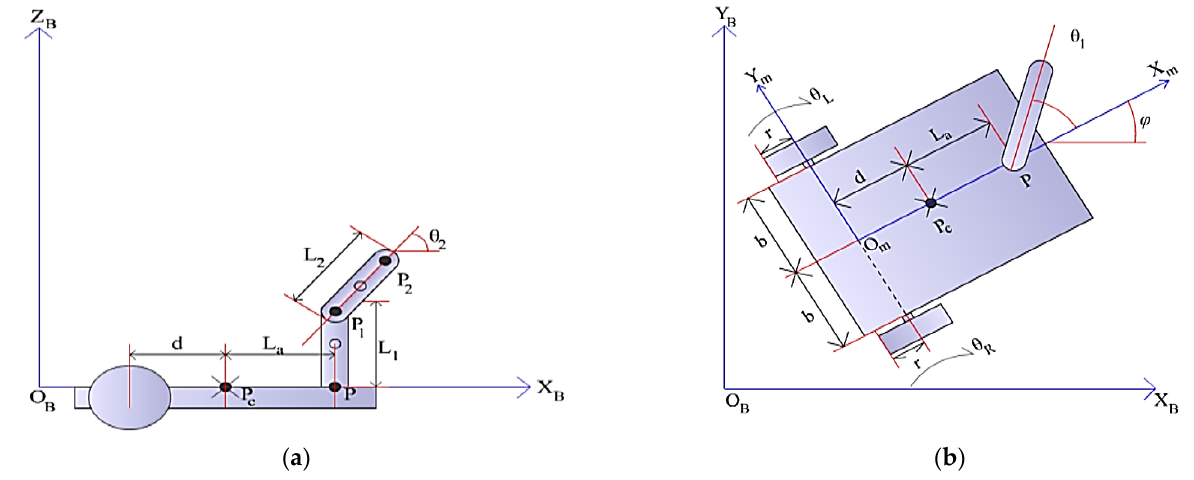
Figure 1. Schematic representation for the robot: ( a ) Side view and ( b ) Top view. The O B X B Y B Z B represents the base coordinate system and the O m X m Y m Z m coordi- nate system is connected to the moving body. O m is selected as the midpoint of the line connecting the two active wheels and the X m axis is perpendicular to the line connecting the two active wheels.